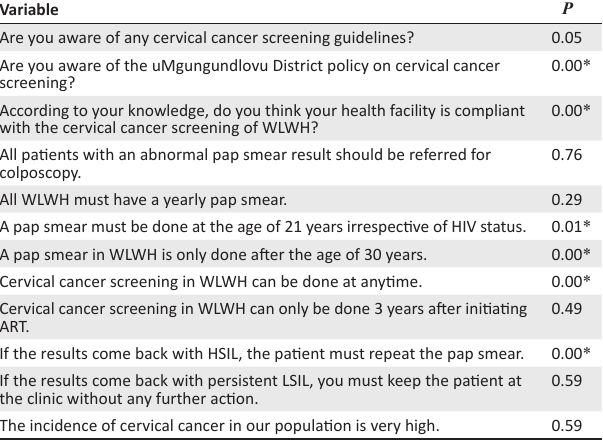
TABLE 4: Association between healthcare workers and variables related to knowledge of